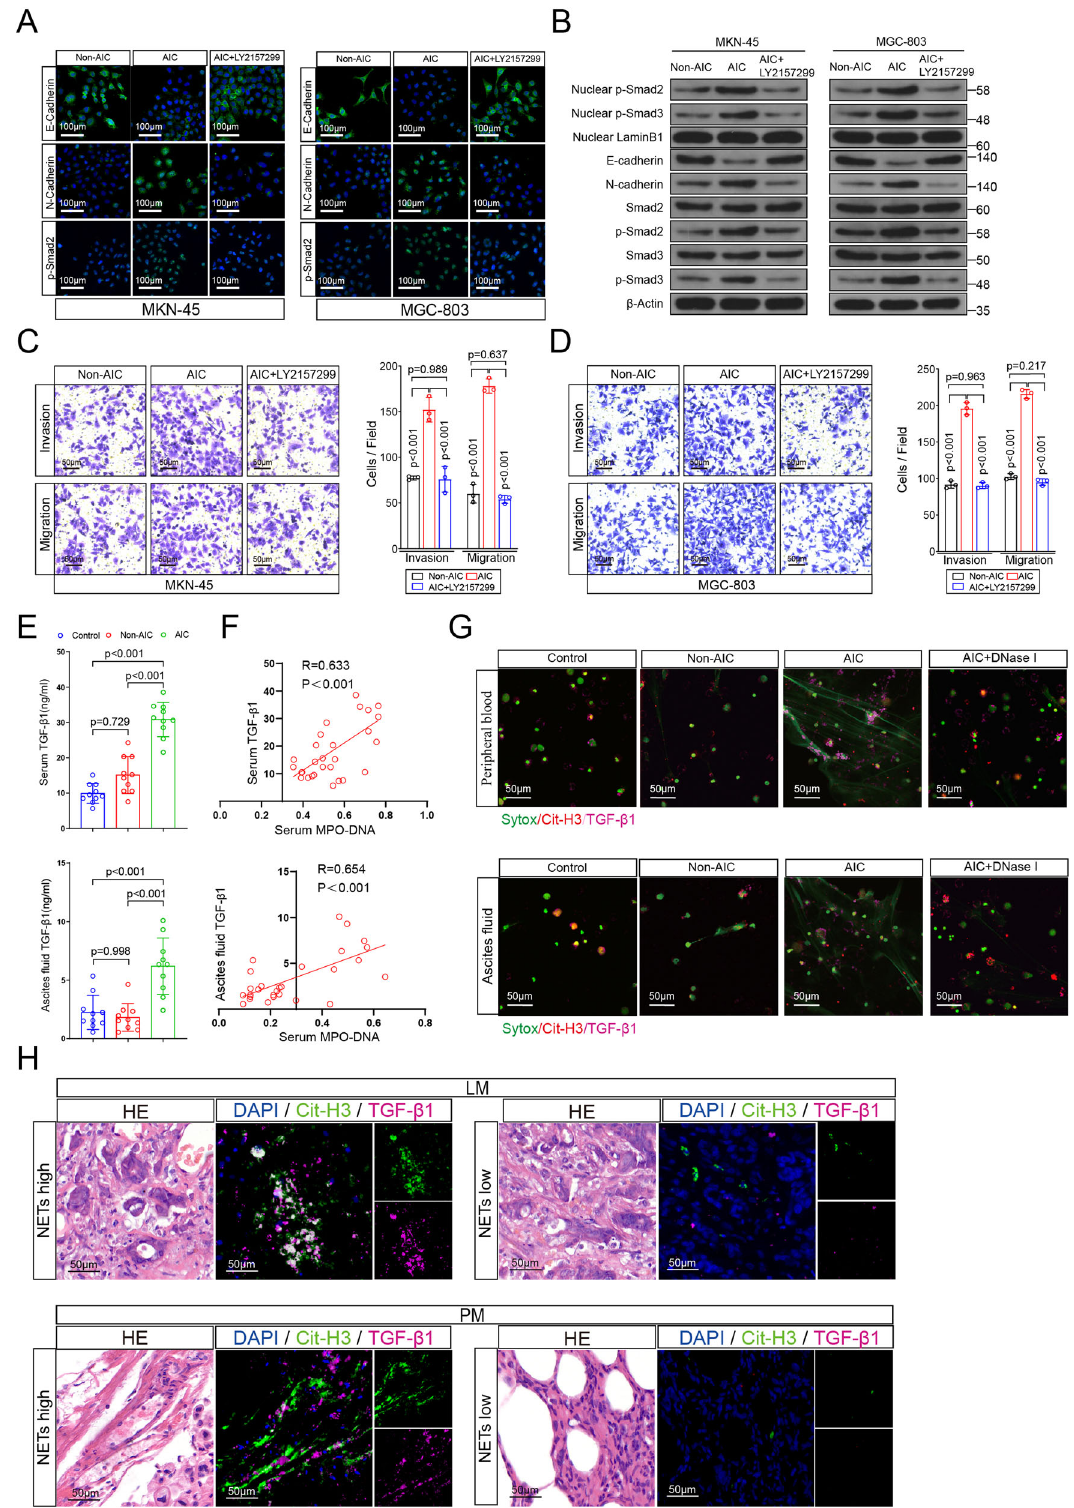
TGF- β inhibitor effectively counteracts NETs-GC clusters induced metastasis but not aggravated sepsis . To further explore NETs-GC clusters involved GC metastasis and its potential therapeutics in vivo, an experiment scheme was designed including sham or CP and LM or PM modeling and then treatment, including PBS, DNase I, or LY 2157299 were administered intraperitoneally every 5 days (Fig. 7A). Figure 7B NATURE COMMUNICATIONS| (2022) 13:1017